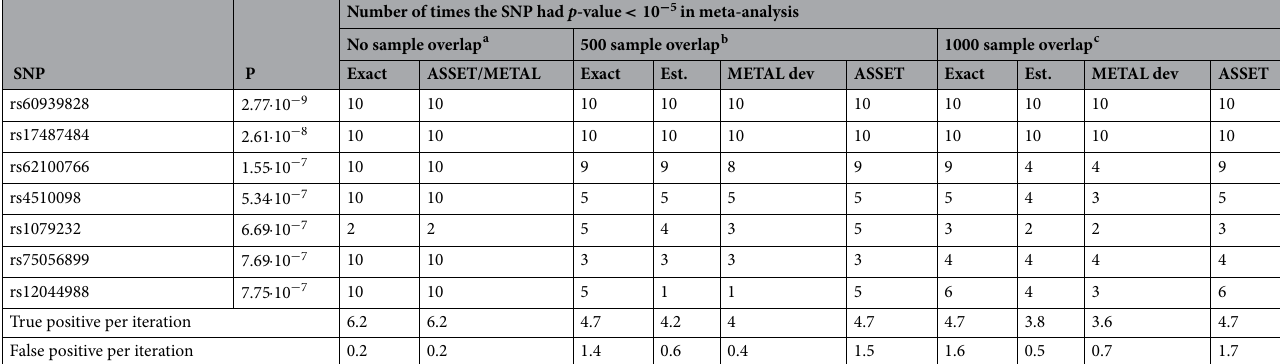
Table 2. Performance of fixed-effect meta-analysis on real genotype data. We applied our method for fixed- effect meta-analysis to the depressive episode trait (ICD F32 Depressive episode) in UK biobank samples and 6 compared the performance of our method vs. ASSET/METAL. SNPs with p -value strictly less than 10 − in the primary GWAS summary statistics using all samples were treated as “true signals”. In each iteration of an experiment, we split the dataset evenly into two, generated GWAS summary statistics for each subset, and meta-analyzed the summary statistics using our method and ASSET/METAL. We reported the number of 6 times (out of ten iterations) that a “true signal” got captured using the “significance threshold” p < 10 − by each method under different sample overlap conditions. METAL dev refers to the latest release in GitHub 28 . Two variants of ReACt are tested: Exact and Est, indicating whether the sample overlap was exactly known as part of the input or whether it was estimated , respectively. Sample overlap indicates the number of cases and controls that were shared between two input studies, ie., 500 sample overlap means that 500 cases and 500 controls were shared between the two studies when the split was carried out. The variable P in the table indicates the p -value of the target SNP in the primary GWAS using all samples. True positive per iteration 6 reports the average number of SNPs with p -value strictly less than 10 − in the primary GWAS that were captured in one iteration; and False positive per iteration reports the average number of extra SNPs being captured in one iteration. a With 9184 cases and 156,425 controls from each subset. b Out of 9434 cases and 156,675 controls from each subset. c Out of 9684 cases and 156,925 controls from each